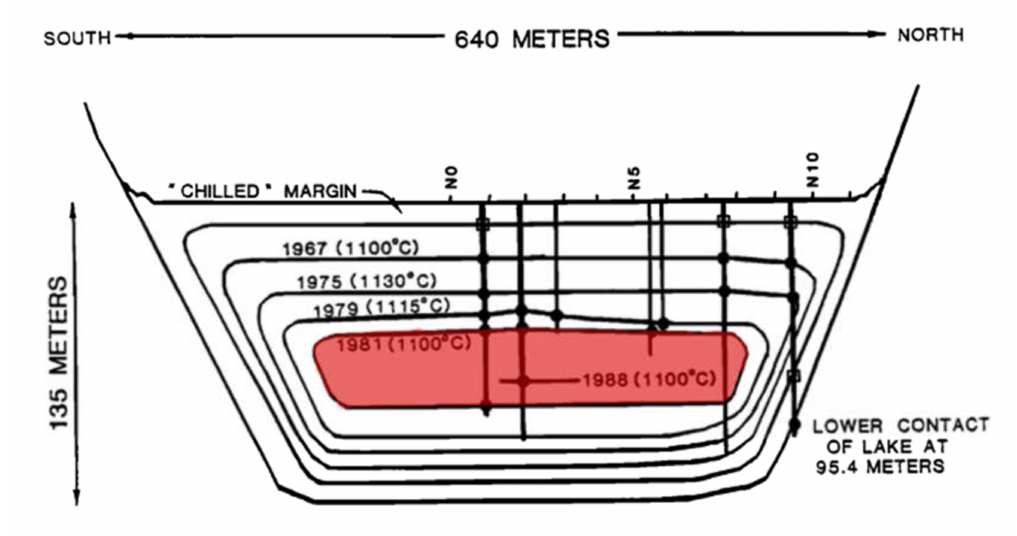
Figure 1. Cross section of Kilauea Iki lava lake showing some of the holes that have been cored and the position of the molten lava lens with time. 1981 (Figure 2A) is shown in red [15]. Table 1 is a compilation of pertinent data and calculation results for magma–hydrothermal